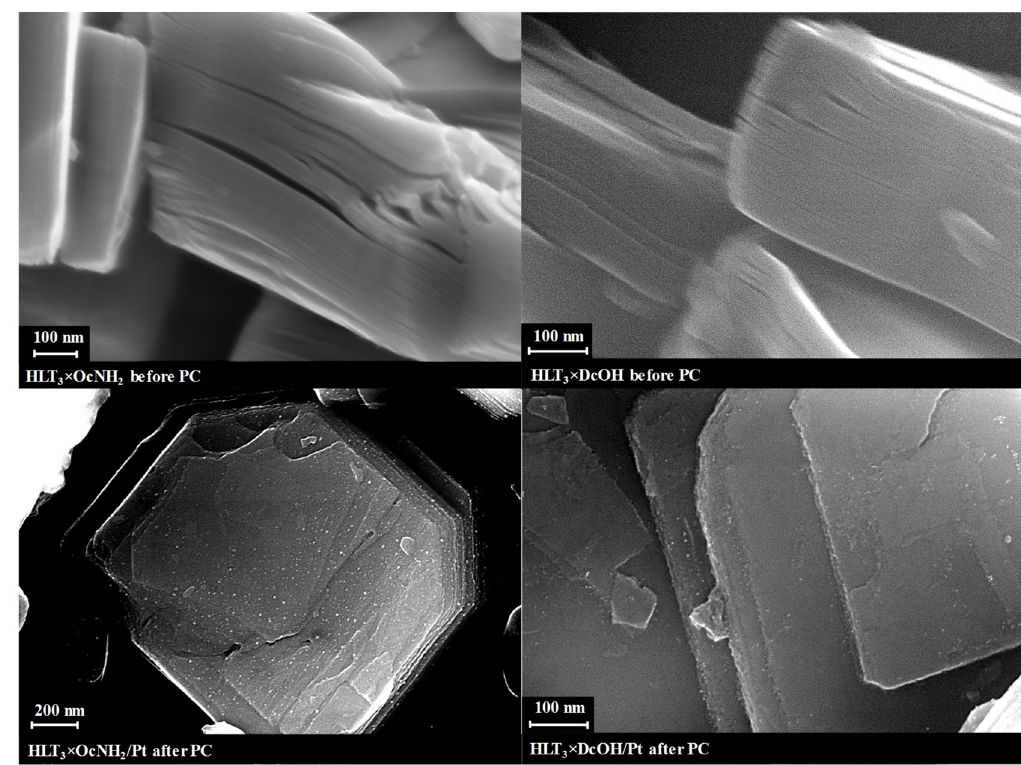
Figure 8. SEM images of some derivatives before and after photocatalytic platinization.